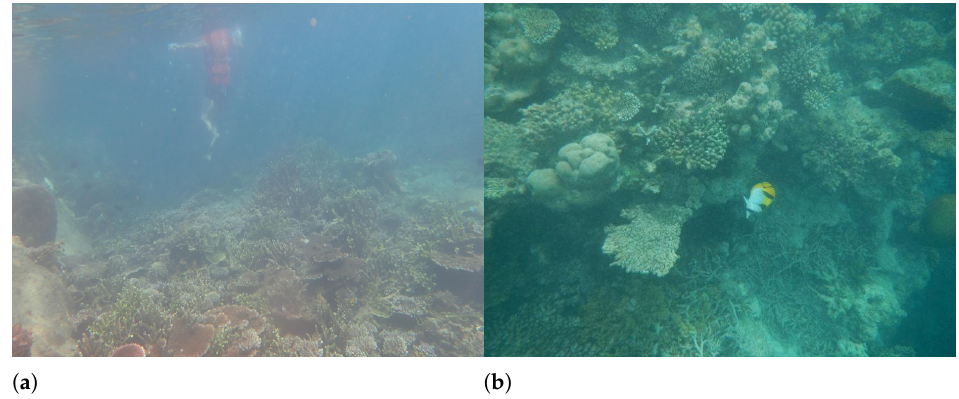
Figure 8. Bliinds2 and FDUM misjudgment example. ( a ) Bliinds2(DMOS) = 8 FDUM = 0.31, ( b ) Bliinds2(DMOS) = 15 FDUM =